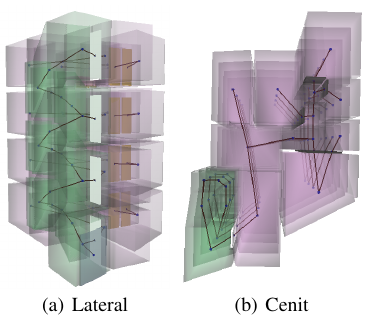
Figure 3. IndoorGML model of the Birmania building